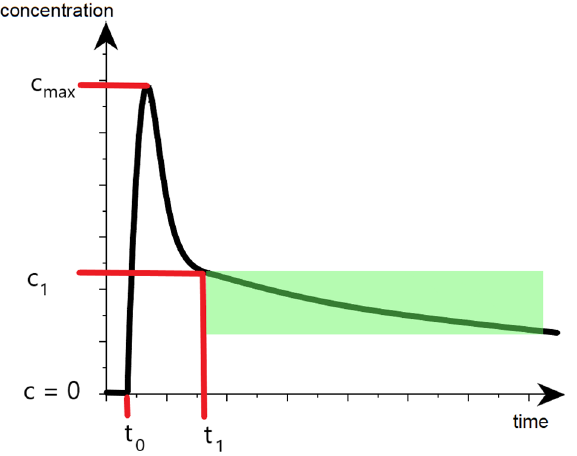
Figure 2. Illustration of diagnostical colorant concentration dynamic during the clearance test. t 0 is the time when the first wave of injected colorant reached the volume under observation, c max stands for concentration peak detected during the recirculation process. The green area is used for experimental PDR calculation.